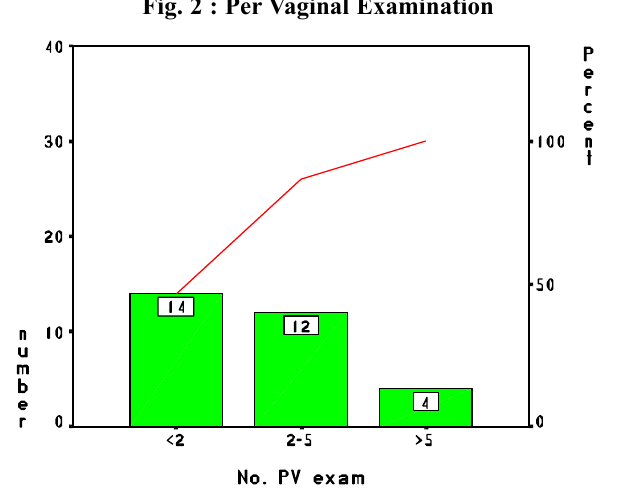
Fig. 2 : Per Vaginal Examination